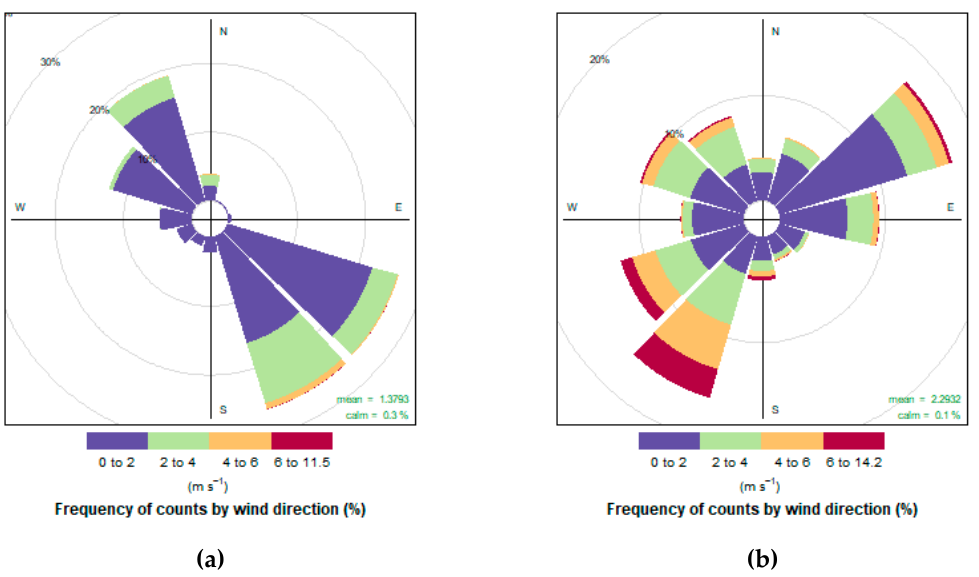
Figure 2. Average frequency of counts by wind speed and wind direction, 2016–2019: ( a ) Tˇrinec-Kosmos; ( b ) V ěřň ovice.